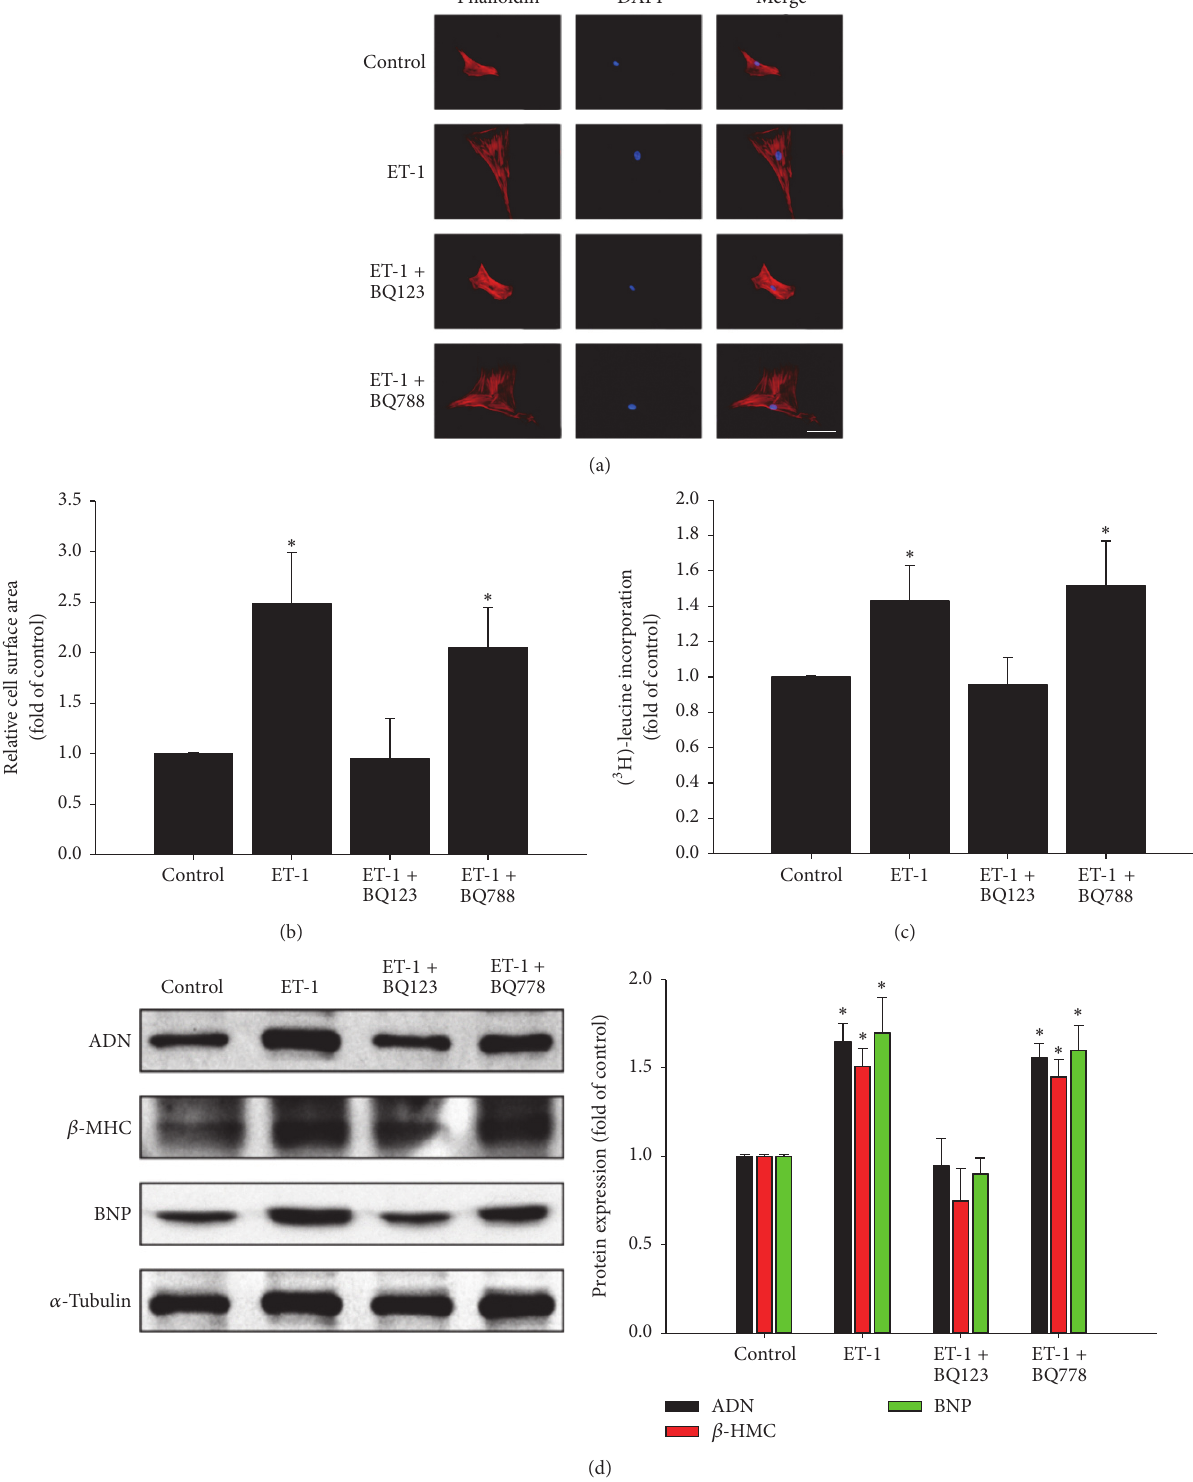
Figure2:ETAreceptorinvolvedinET-1-dependenthypertrophyandadiponectinexpression.TheroleofET-1receptorandET-1inmyocardial cell size was determined in cells pretreated with ETA receptor antagonist (BQ123) or ETB receptor antagonist (BQ788) for 1h, followed by stimulation with or without ET-1 (50nM) for 48 h. Cells were fixed and stained with rhodamine-phalloidin (red) and DAPI (blue) followed by cell surface area quantitation (scale bar, 50 𝜇 m) (a). Data are expressed as mean ± SEM of values from three independent experiments (b). 3 H-leucine incorporation was determined as a measure of relative protein synthesis (c). Immunoblot assay and quantification of adiponectin (AND), beta-myosin heavy chain ( 𝛽 -MHC), and B-type natriuretic peptide (BNP) expression were also demonstrated (d). ∗ 𝑃 < 0.05 , compared with untreated control